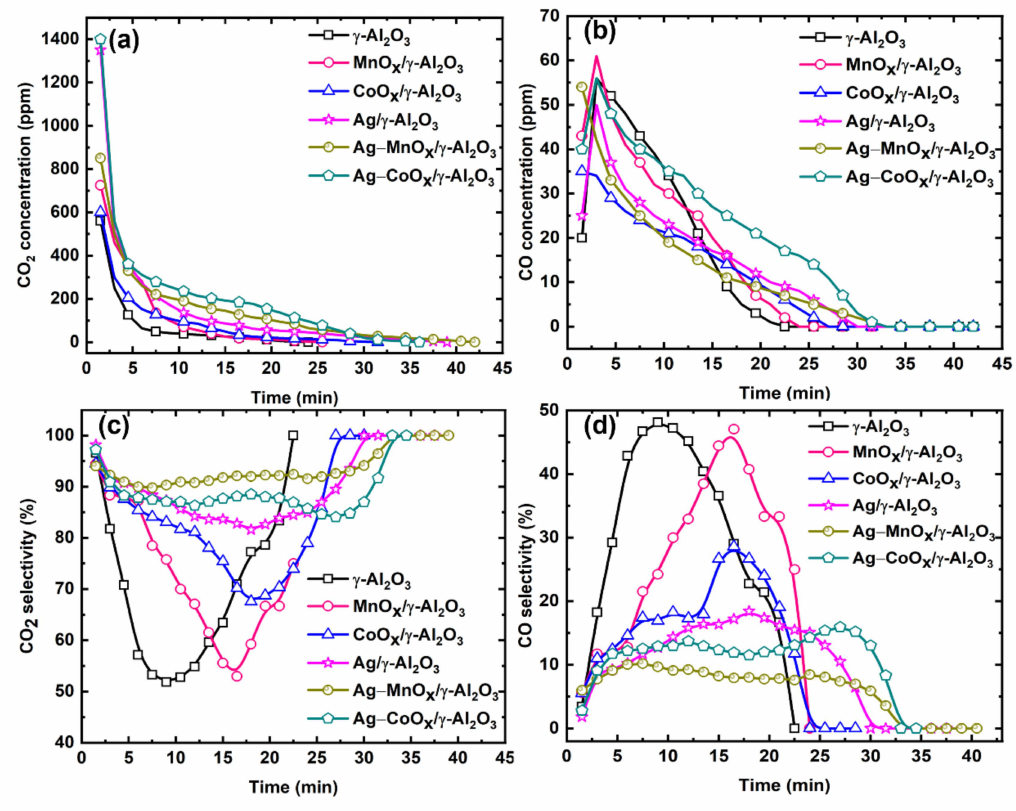
Figure 6. Variation of ( a ) CO 2, ( b ) CO, ( c ) CO 2 selectivity, and ( d ) CO selectivity with time obtained during ozone treatment.